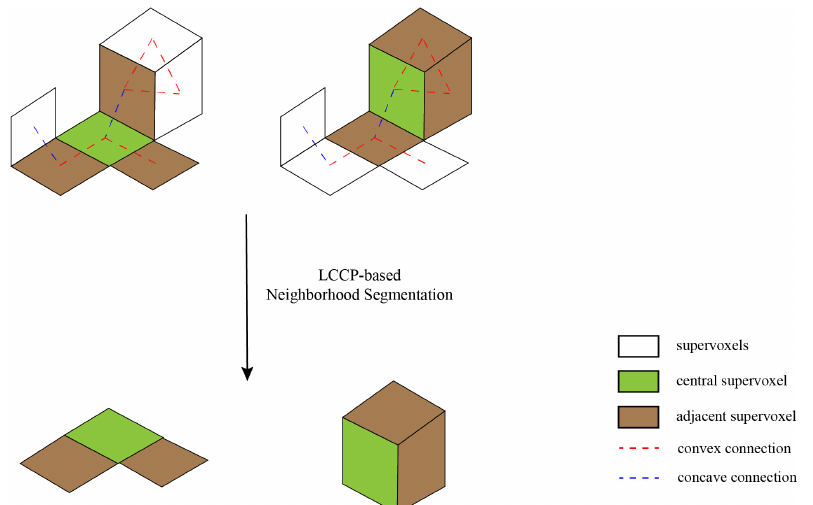
Figure 3. Locally convex connected patches (LCCP) neighborhood optimization. The neighborhood ranges used to calculate eigenvalues are shown at the